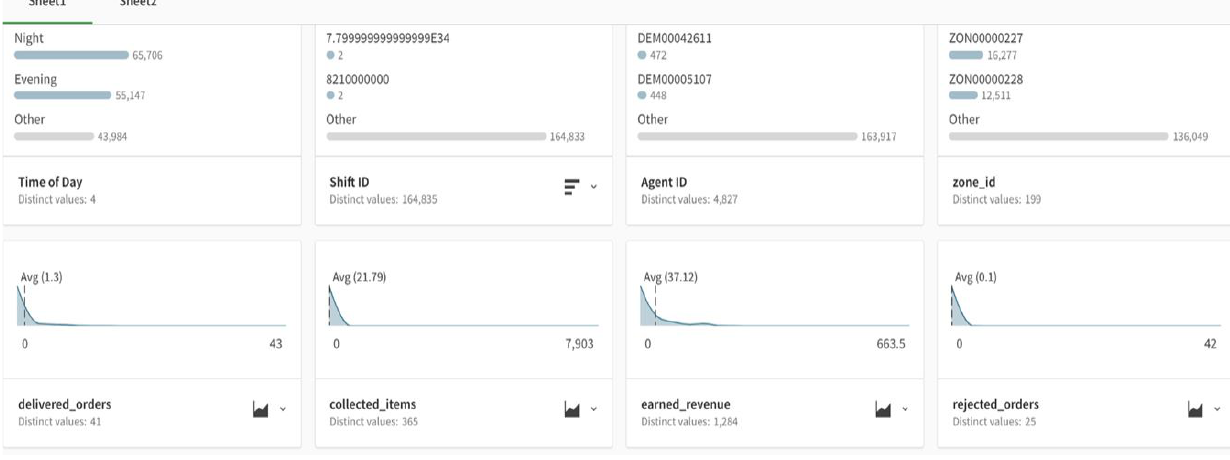
Figure 4. Snapshot of auto-generated data profiling in the AA approach.